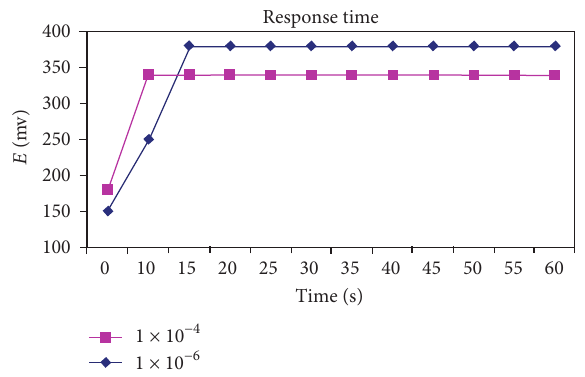
F 4: e effect of the time on potentiometric response of Sn